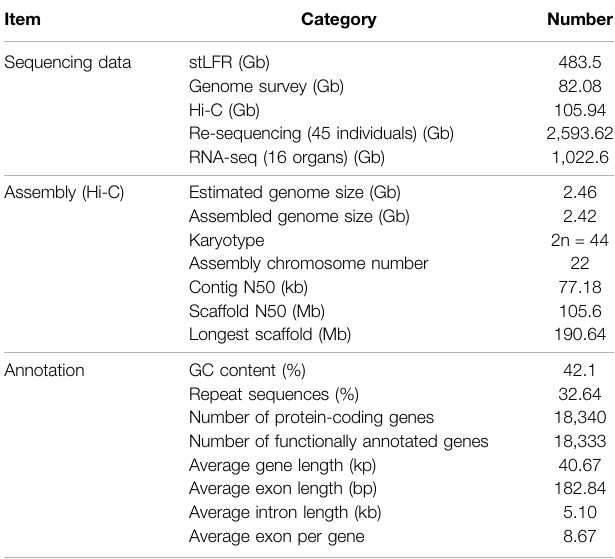
TABLE 1 | Global statistics of sequencing data, genome assembly, and annotation of P. larvata